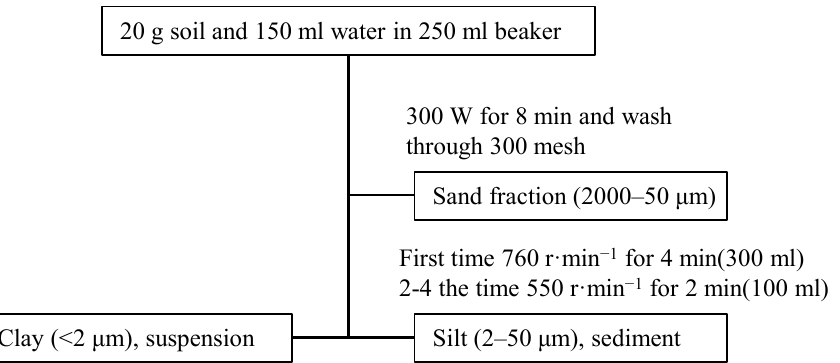
Figure 2. Flow chart of soil particle-size fractionation.